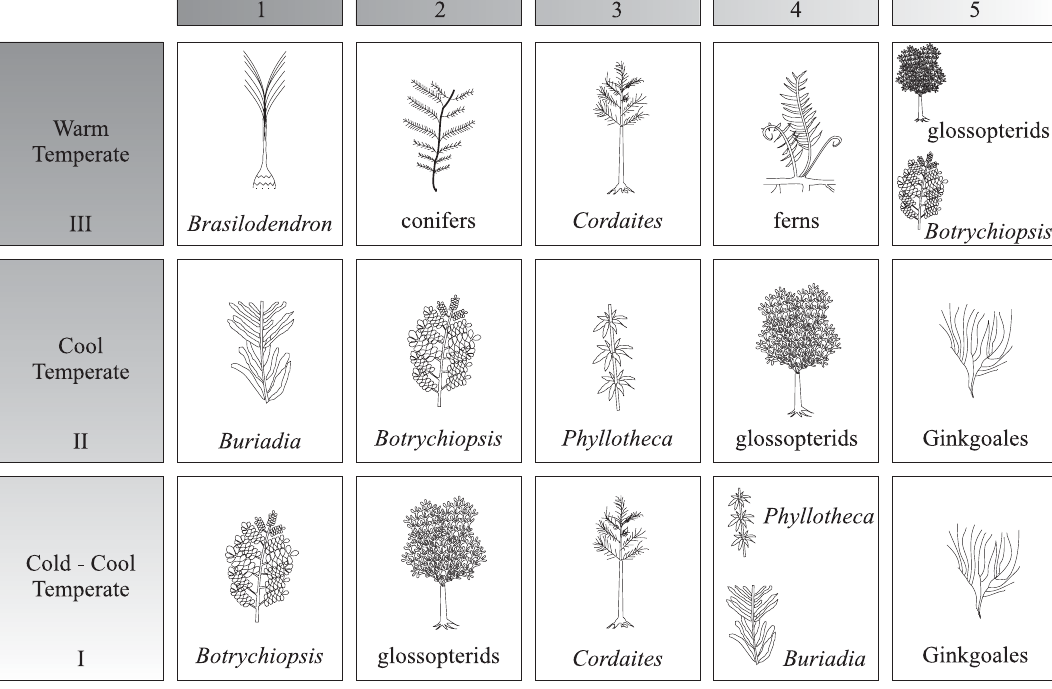
Fig. 8 – Megafloristic associations in biomes at cold-cool, cool and warm temperate climates in the Lower and Midle/Upper Permian in Southernmost Paraná Basin, Brazil. (1) Predominant; (2) Abundant; (3) Commom; (4) Less commom; (5) Rare. (I) Asselian wet biome; (II) Sakmarian/Artinskian wet biome; (III) Kungurian wet